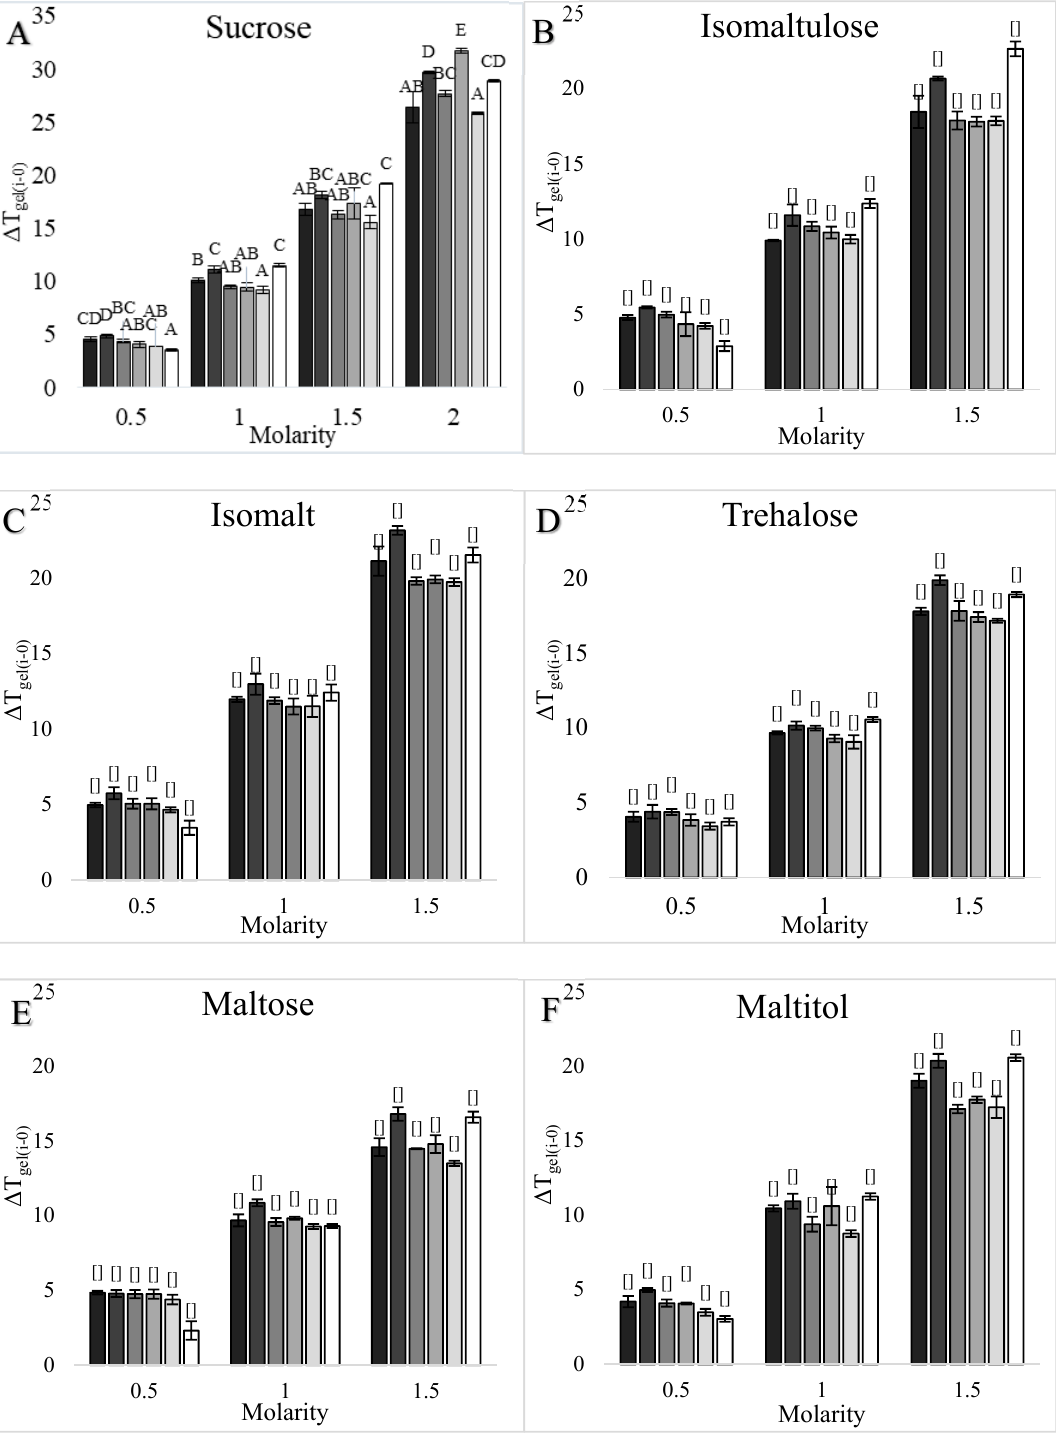
Figure 4. E ff ects of increasing concentrations (0.5–2.0 M) of 12-carbon sweeteners in solution on the onset T gel of di ff erent types of starch: ( A ) sucrose, ( B ) isomaltulose, ( C ) isomalt, ( D ) trehalose, ( E ) maltose, and ( F ) maltitol. Starch from left to right as waxy corn ( █ ), dent corn ( █ ), HACS55 ( █ ), HACS70 ( █ ), potato ( █ ), and wheat starch ( █ ). The increase in the onset T gel in the sweetener solution compared to the onset T gel in water ( ∆ T gel( i- 0) ) is plotted. Error bars are 1 standard deviation, n = 3 , and the capital letters indicate significant differences between T gel s.